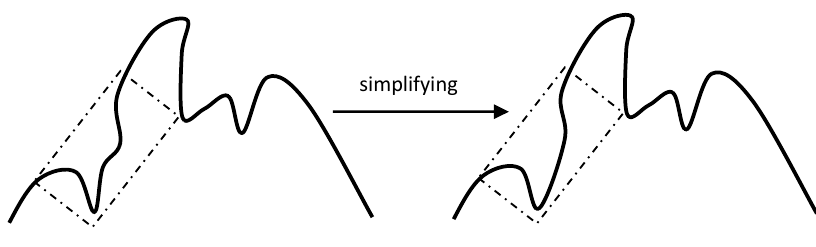
Figure 14. The method of simplifying small curves.